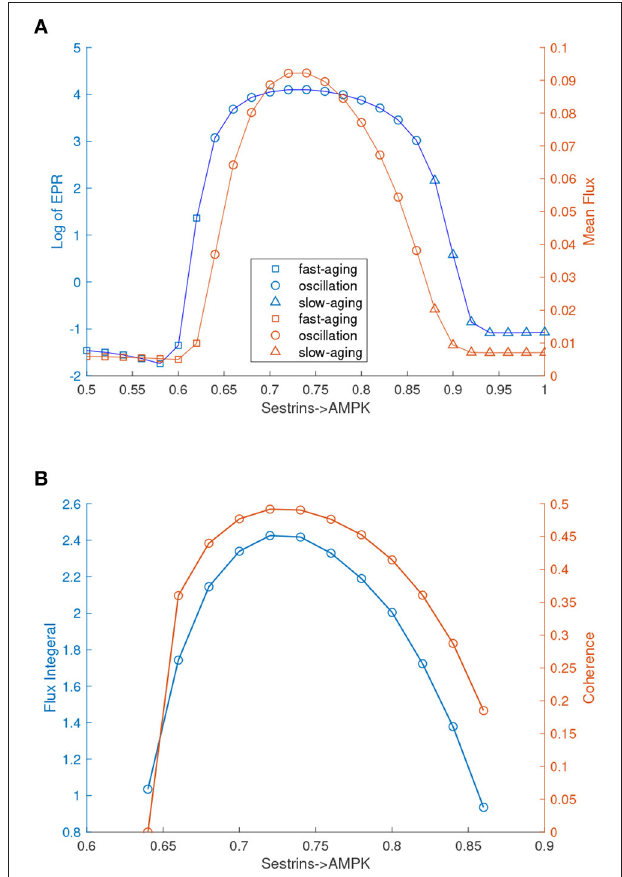
FIGURE 8 | EPR, flux, and coherence changes upon the regulation changes of Sestrins->AMPK through the transitions from the monostable fast-aging state to the oscillation between the fast-aging state and the slow-aging state, and then to the slow-aging state. (A) The entropy production rate and the mean flux of the monostability and the oscillation. (B) The flux integral and the coherence of oscillations.